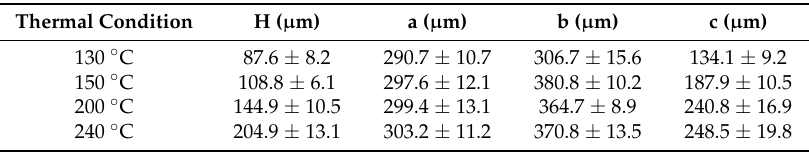
Table 3. Measured filament dimensions of 3D-printed PPS samples.